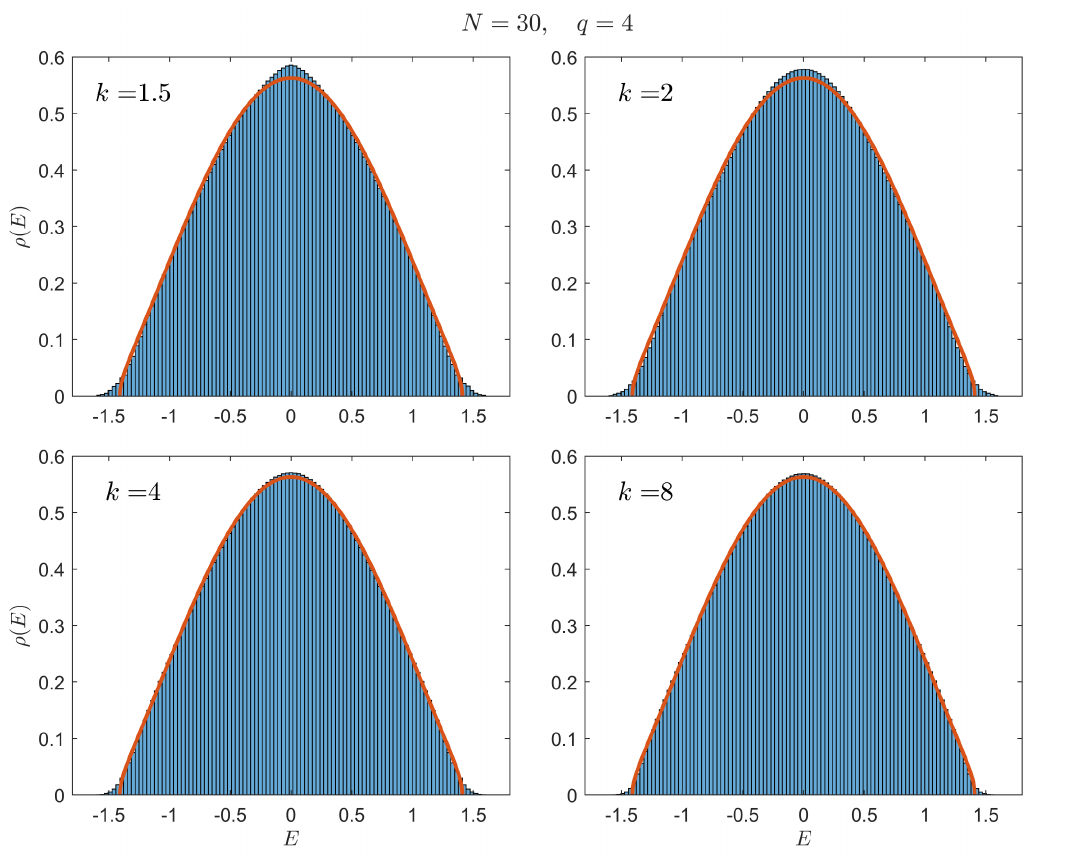
Figure 8 . A histogram of the spectral density of the sparse SYK Hamiltonian averaged over 100 disorder realizations for various values of k . For comparison the solid red line is the Q –Gaussian approximation to the spectral density